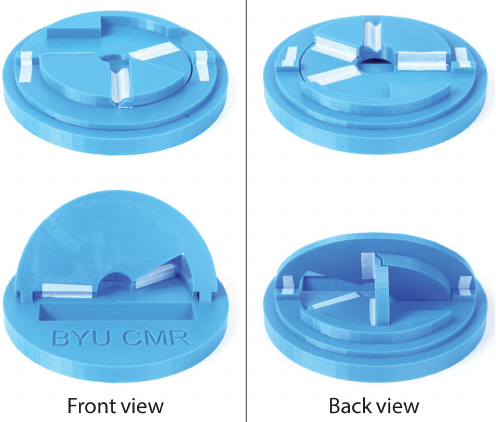
Figure 29. Desk mobile phone holder in stowed and deployed